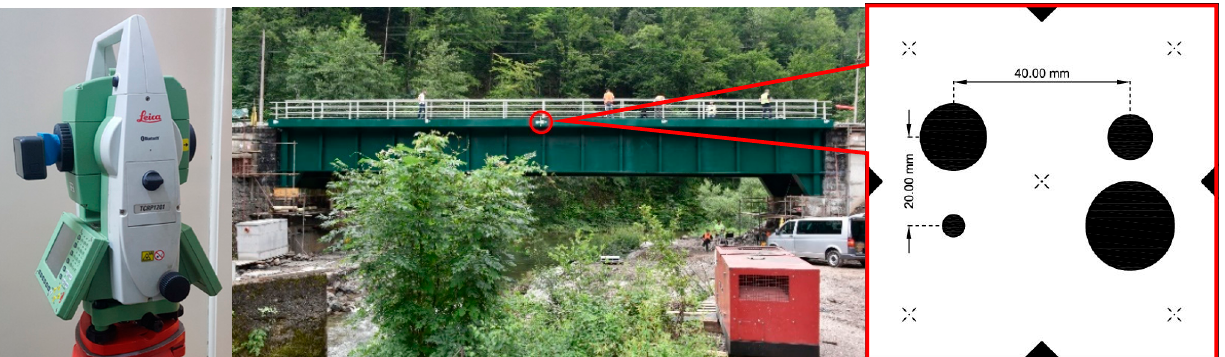
Figure 12. IATS prototype ( left ), railway bridge Kloštar over the river Dobra ( middle ), and photo mark ( right ).